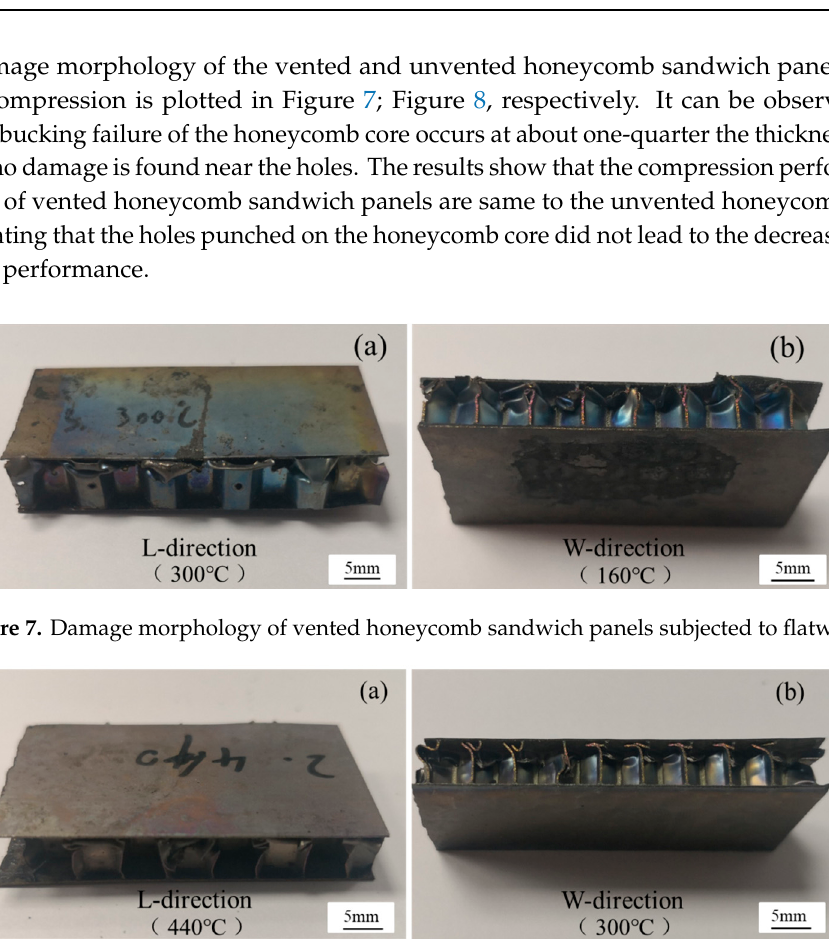
Figure 8. Damage morphology of unvented honeycomb sandwich panels subjected to flatwise.